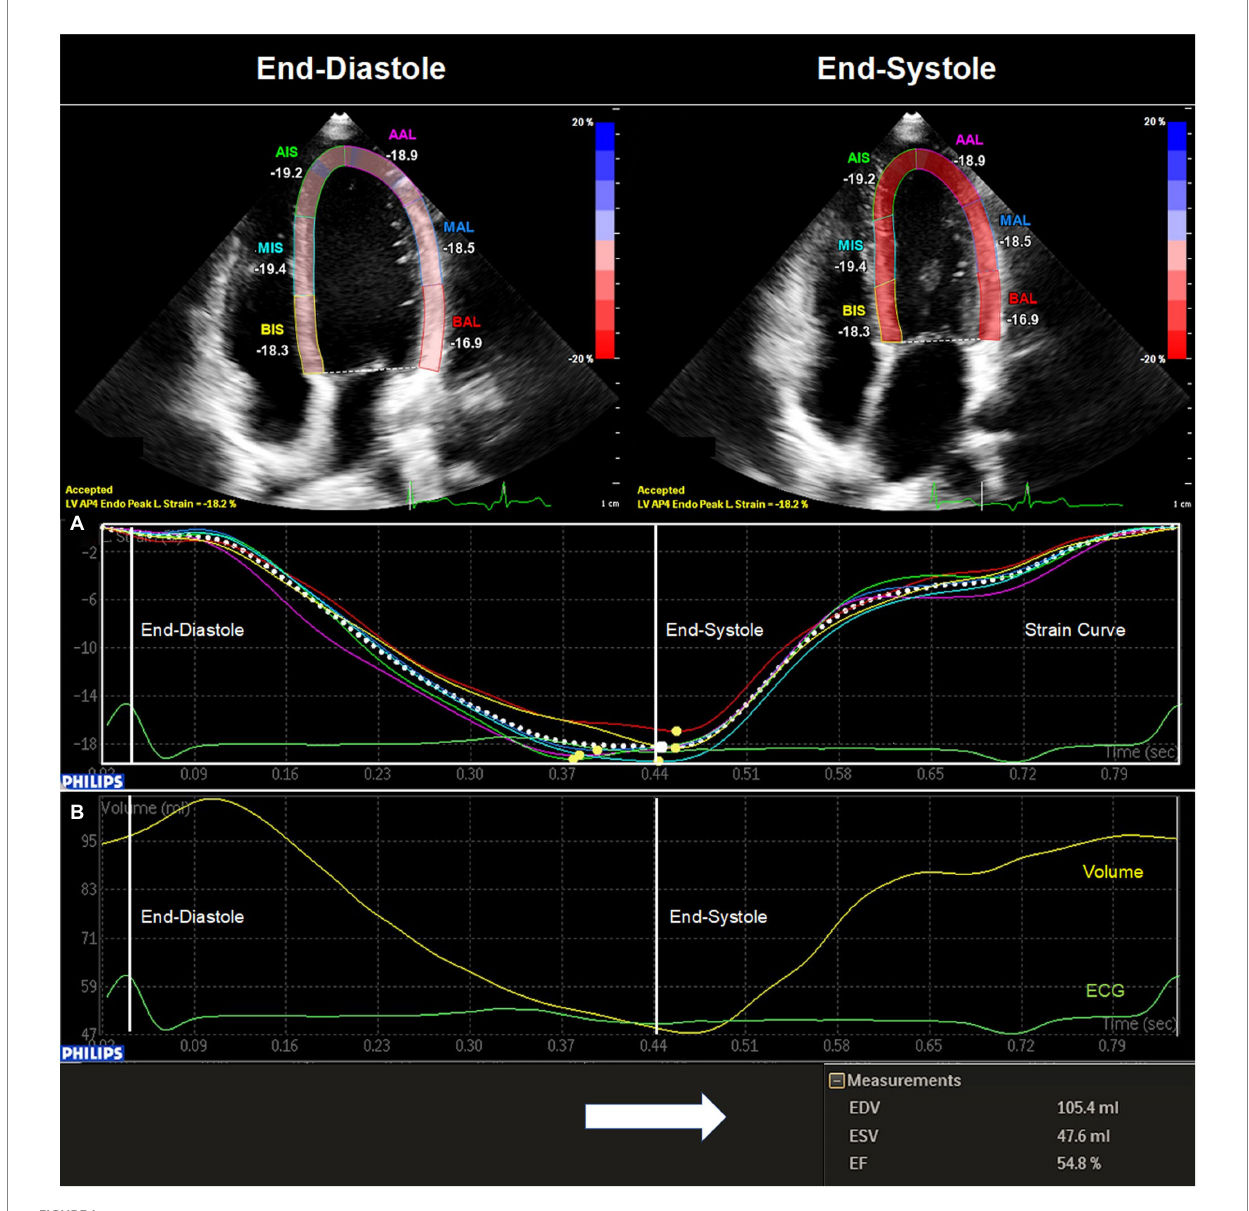
FIGURE 1 Two-dimensional speckle tracking echocardiography of the left ventricle. The image was acquired through echocardiography in apical four chamber view and transferred to an offline workstation (QLAB cardiovascular ultrasound quantification software, version 11.1, Philips Healthcare, The Netherlands) for further analysis. In end-diastole (QRS in ECG) the investigator marked the endocardium at three fixed points. The endocardium was then automatically marked at end-diastole by the software. The investigator could manually adjust the region of interest at end-diastole and at end- systole (end of T-wave in ECG) if necessary. (A) Global peak longitudinal strain for apical four chamber view (GPLS_A4C, %) was then automatically assessed by the software at end-systole. (B) In addition, a left ventricular volume curve was generated enabling the calculation of left ventricular end- diastolic volume (EDV, mL), left ventricular end-systolic volume (ESV, mL), and left ventricular ejection fraction (EF,